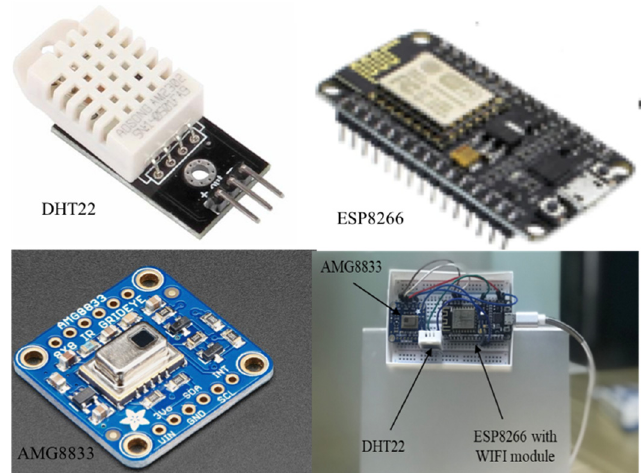
Figure 4. The non-intrusive sensor board.